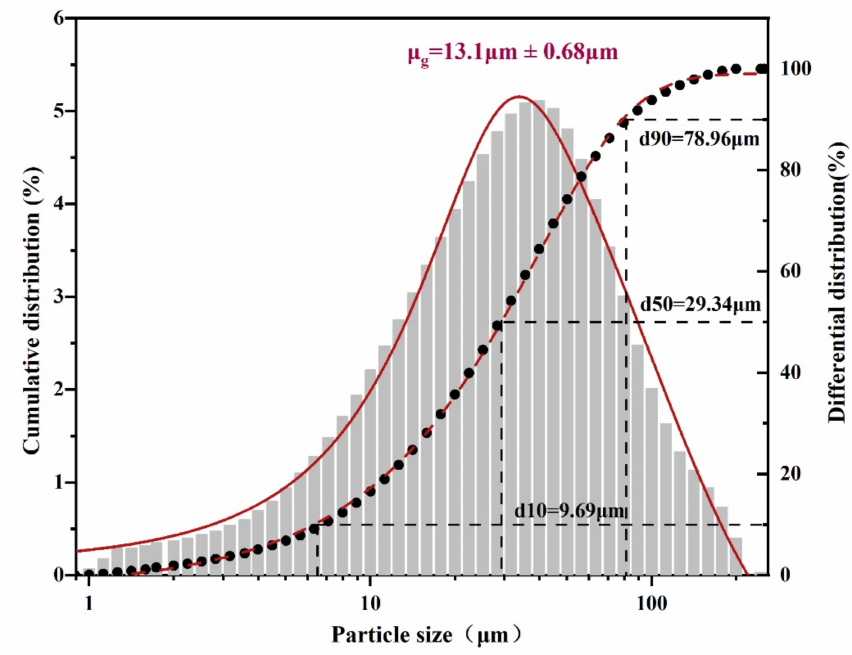
Figure 4. Results of PG particle size